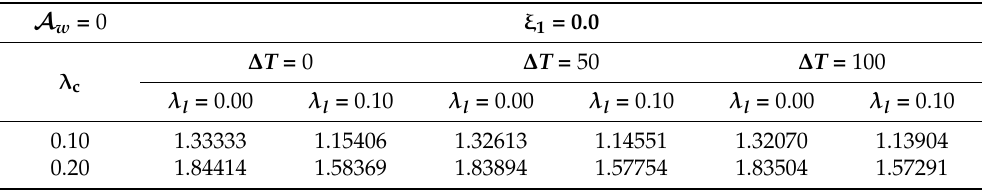
Table 6. Linear dimensionless natural frequencies of porous FG clamped–clamped (C–C) nano-beam for ξ 1 =